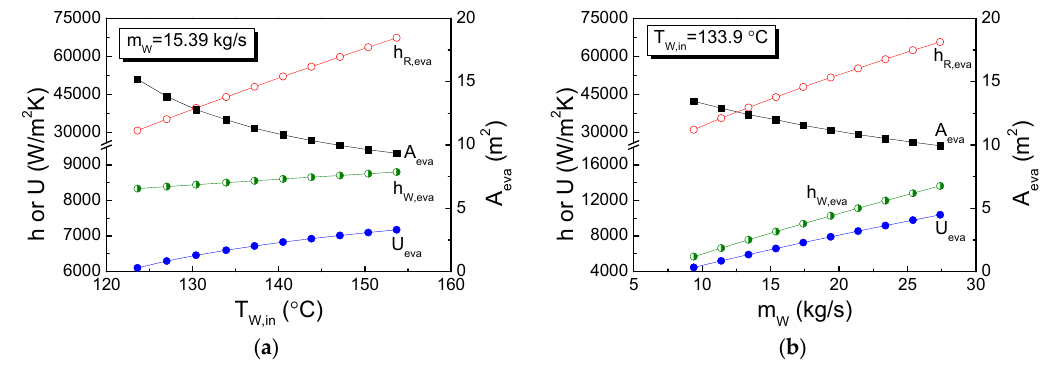
Figure 6. Evaporator heat transfer coefficient and heat transfer area as functions of ( a ) T W,in and ( b ) m W .